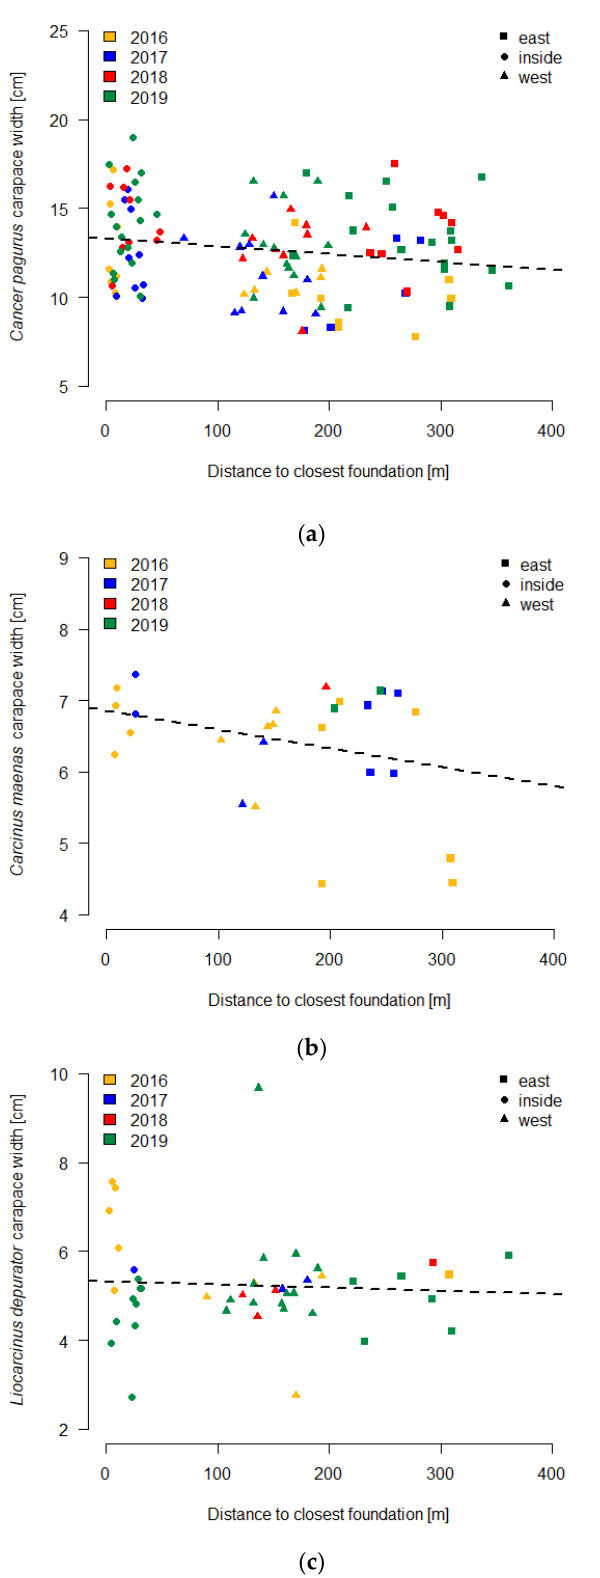
Figure 8. Average carapace width per decapod species: ( a ) Cancer pagurus , ( b ) Carcinus maenas , and ( c ) Liocarcinus depurator captured with large cages in 2016 – 2019. Black dashed line represents a pooled regression line for all years.